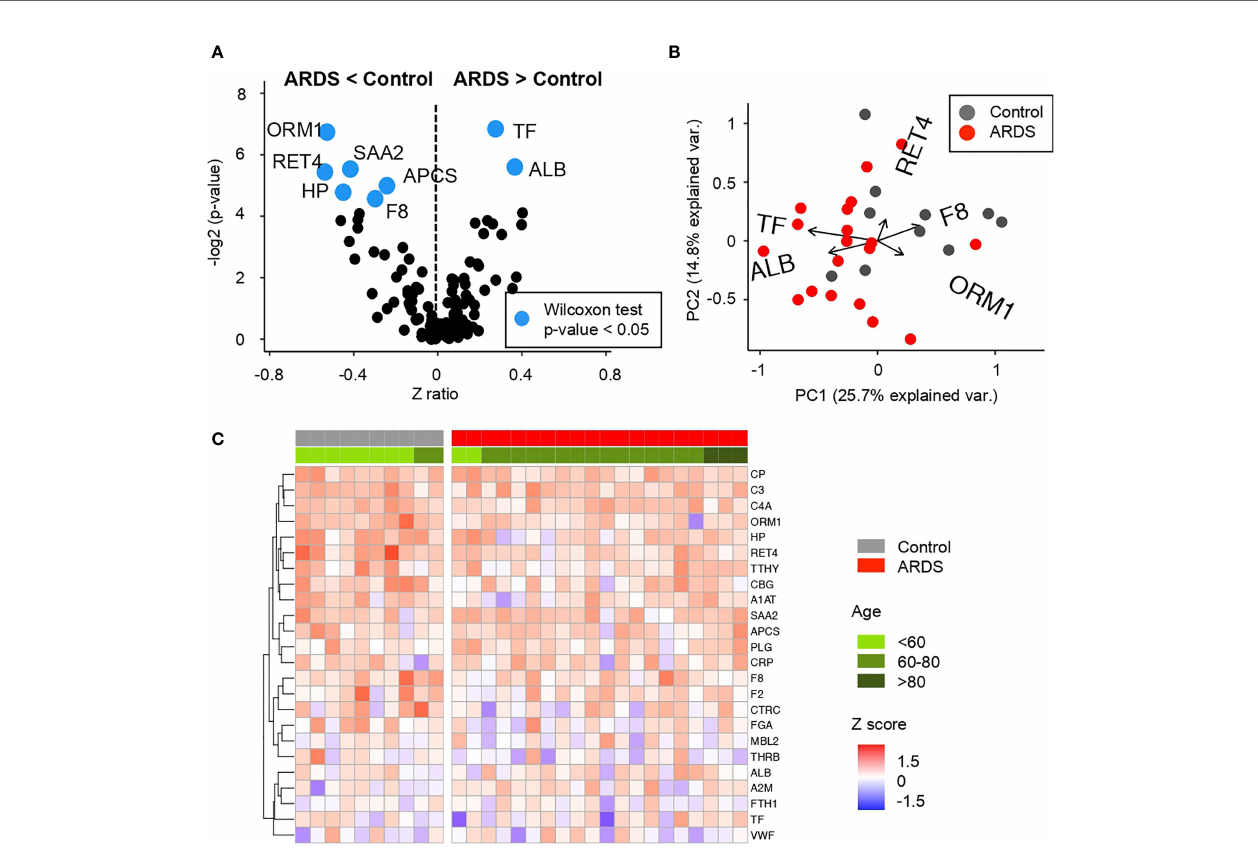
FIGURE 2 | Comparative analysis of the Z scores between control and ARDS patients in the cohort 1 obtained from the microarray for Acute Phase reactants (A) Volcano plot summarizing the statistical signi fi cance of Z score ratios between control and ARDS patients in the cohort 1 (X-axis). The difference between means was evaluated at 1:500 and 1:5,000 dilutions applying Wilcoxon Rank Sum test (Y-axis). Acute Phase reactants showing statistically signi fi cant mean differences are highlighted in blue and larger dots. (B) Canonical biplot representing the PCA of the microarray for Acute Phase reactants both at 1:500 and 1:5,000 dilutions employed in the cohort 1. Dots represent samples and vectors the protein variable contribution to the fi rst two principal components at X and Y-axes. The biplot only highlights the most exemplary protein variables. (C) Heat map describing Z score values obtained from the microarray for Acute Phase reactants in 1:5,000 dilution in the cohort 1. Samples are separated by clinical symptoms (red and gray labeled columns) and ordered according to patient age (green color